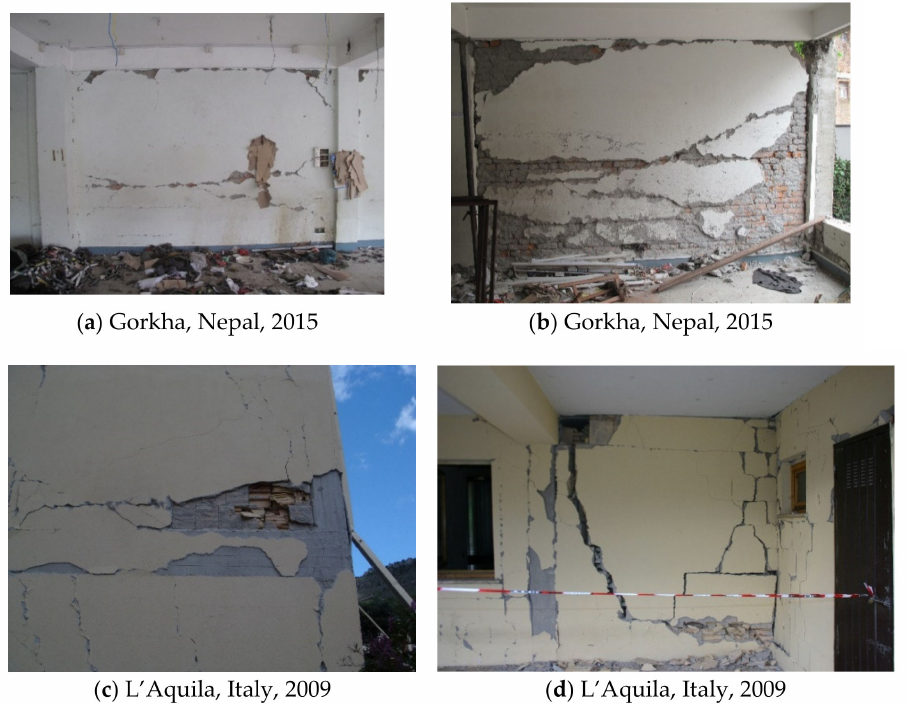
Figure 21. Damage type 10—damage in infill panels: ( a , b ) sliding cracking; ( c , d ) corner crushing.